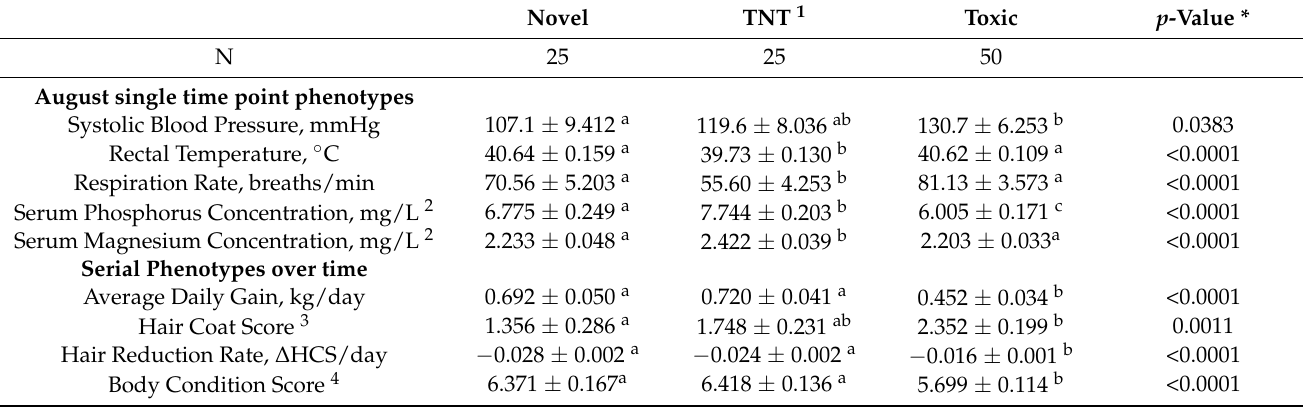
Table 1. Least square means ± standard error for phenotypes significantly impacted by fescue pasture